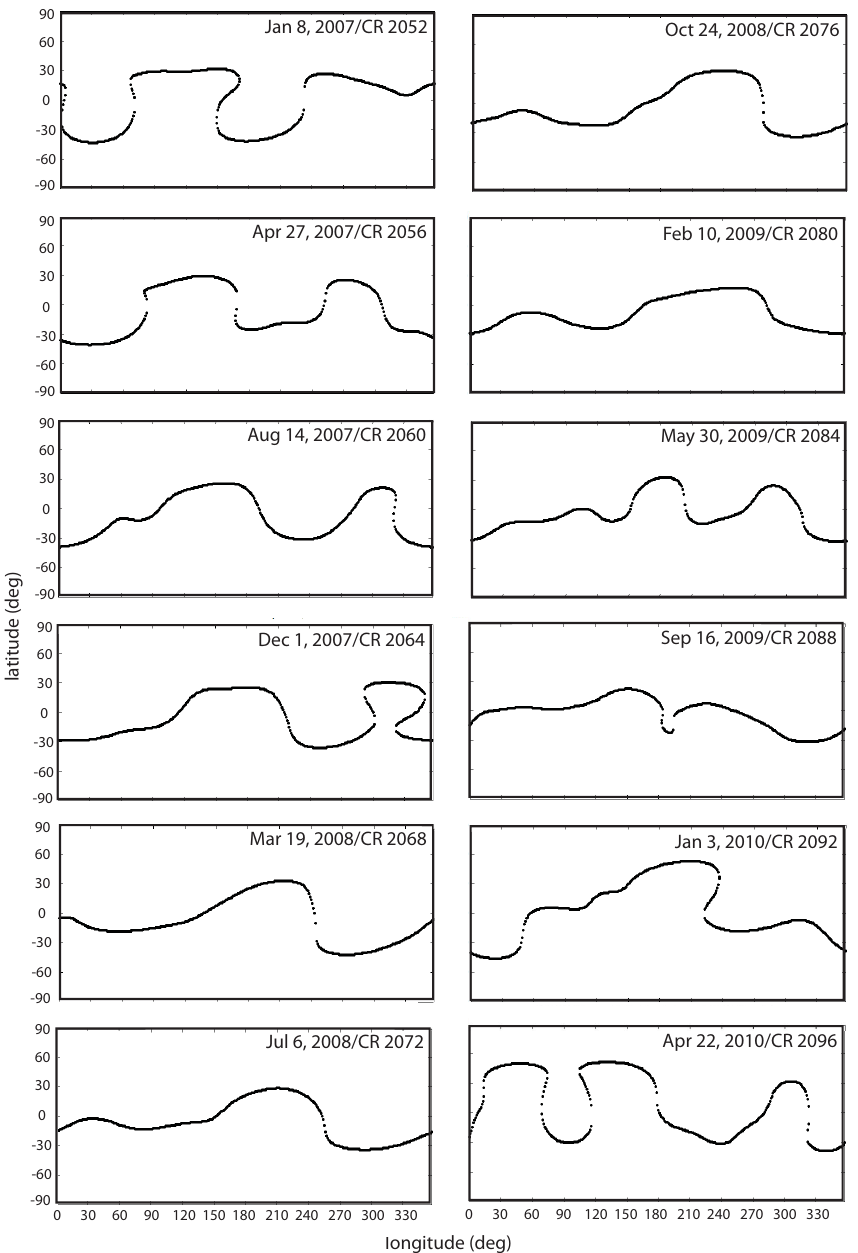
Fig. 5. Source surface synoptic maps from the Mount Wilson Observatory and GONG for selected Carrington rotations during the SC 23 minima. The black line indicates the neutral line. The date indicated give the start time of each Carrington